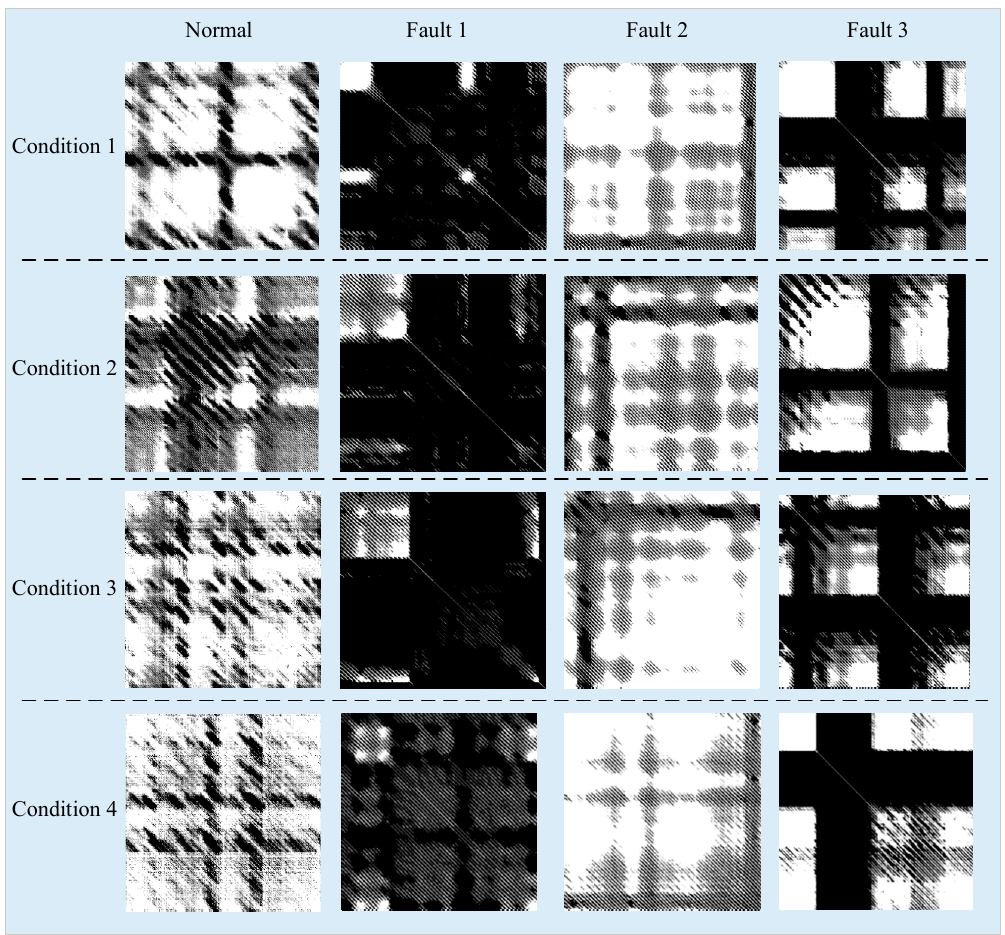
Figure 15. RPs transformed by fault mode vibration data under different conditions.